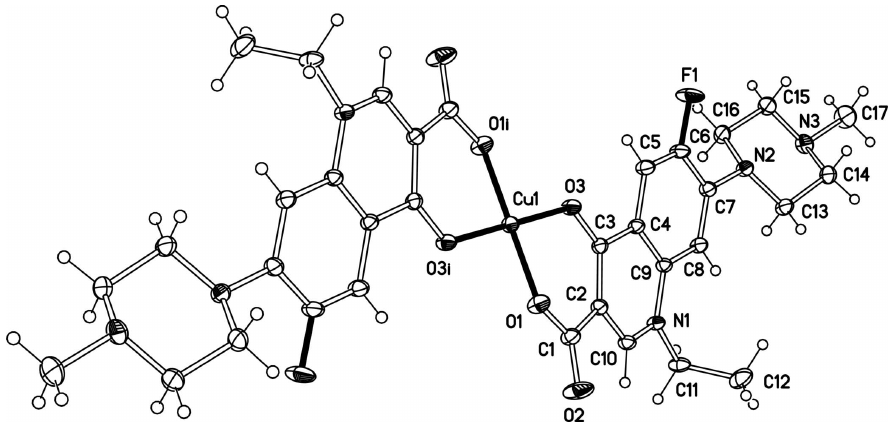
The molecular structure of (I), show the Cu coordination, showing 50% displacement ellipsoids (arbitrary spheres for the H atoms). [Symmetry code: (i) 1–x, 1–y,